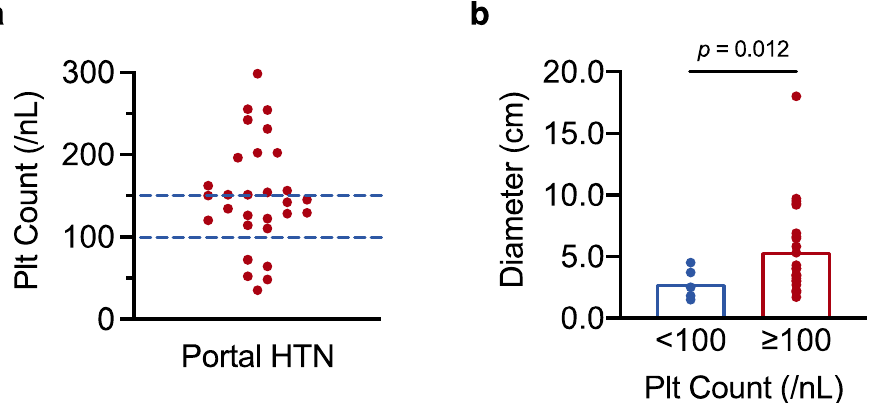
Figure 5. Platelet counts in the normal range do not rule out portal hypertension in resectable HCC. ( a ) Scatter plot showing individual platelet counts in the 29 patients with confirmed portal hypertension (HTN). ( b ) t -test analysis of the 29 patients with portal hypertension, comparing maximum tumour diameter in patients with platelet counts <100/nL and ≥ 100/nL. Results with a p -value < 0.05 were considered statistically significant.